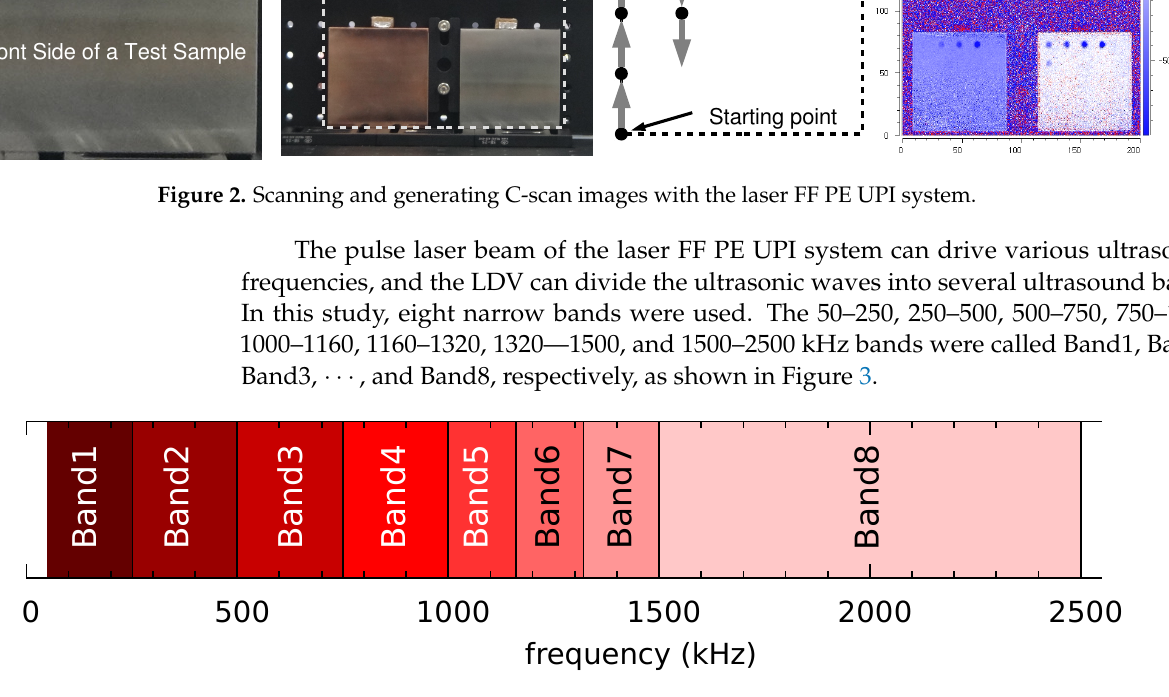
Figure 3. Illustration of the selected ultrasonic narrow bands and the